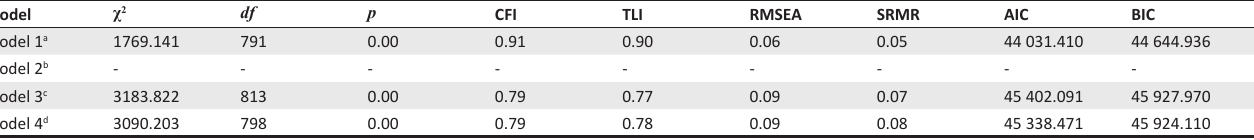
TABLE 1 : Results for the different measurement